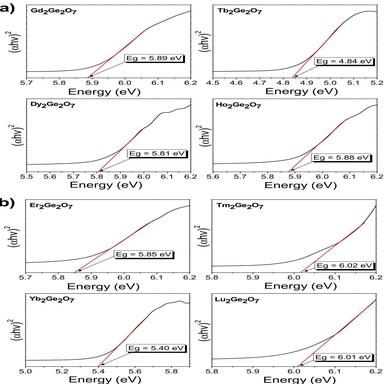
Energy gap (Eg) for the tetragonal pyrogermanates: (a) Gd2Ge2O7, Tb2Ge2O7, Dy2Ge2O7, and Ho2Ge2O7; (b) Er2Ge2O7, Tm2Ge2O7, Yb2Ge2O7, and Lu2Ge2O7.